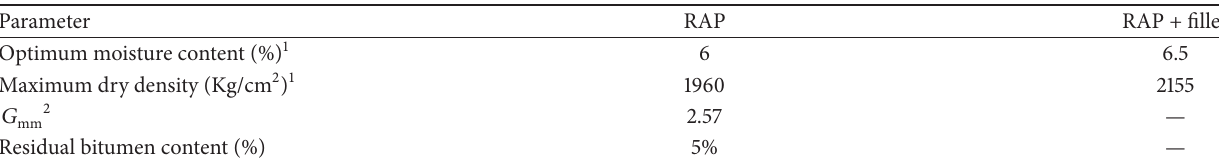
Table 1: Basic characteristics of RAP materials.